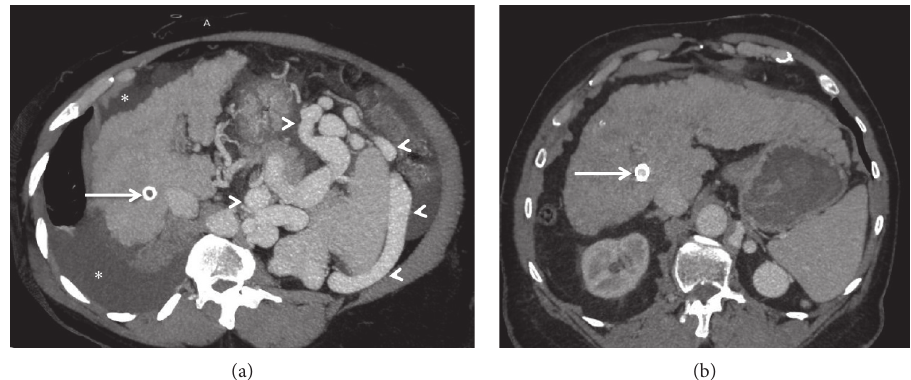
Figure 12: Axial CECT images depicting a large and tortuous splenorenal shunt (SRS; arrowheads) with thrombosed TIPS stent (arrow in (a)). In addition, the image shows recurrence of ascites and hydrothorax (asterisk) for which TIPS was done. The patient underwent occlusion of the SRS and revision of TIPS stent. The postprocedure image shows patent TIPS stent (arrow in (b)) with nonvisualization of SRS and the absence of